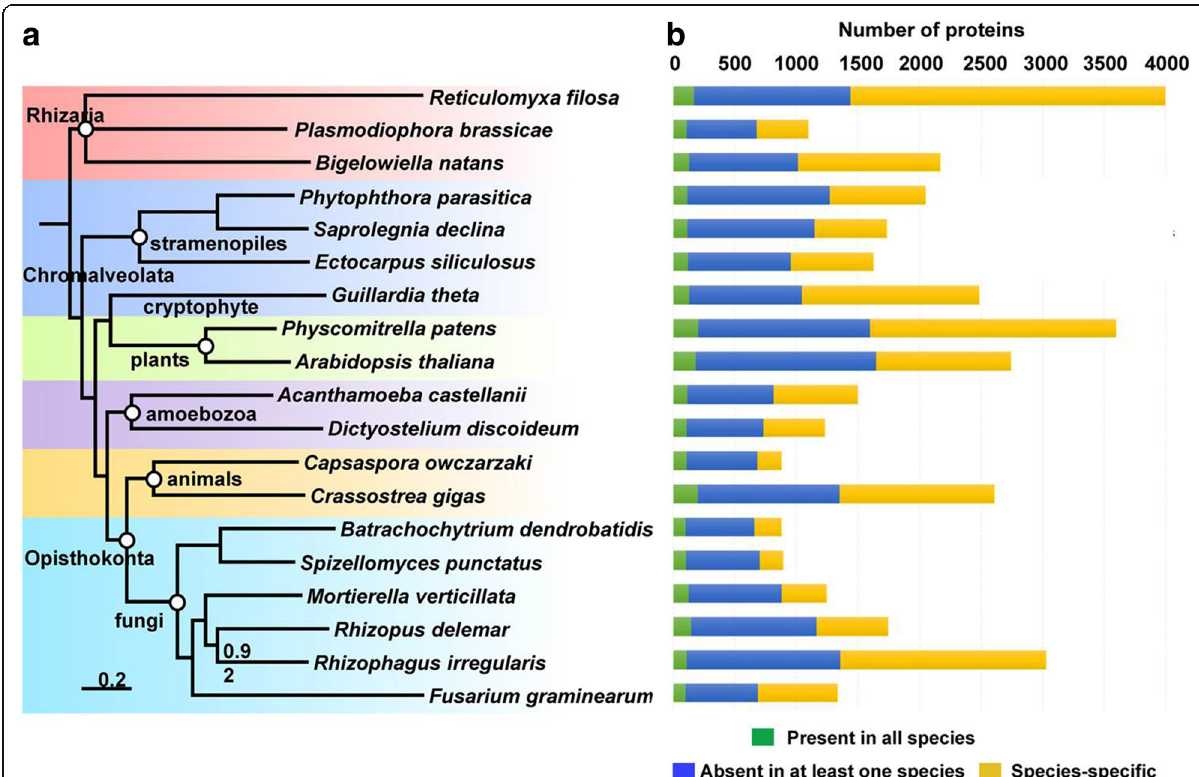
Fig. 2 Phylogeny and ortholog distribution in Plasmodiophora brassicae and other species. a The phylogeny was constructed by the maximum likelihood method from a concatenated alignment of 90 single-copy orthologs conserved across species. The scale bar of branch length represents 0.2 amino acid-substitutions/site, and the bootstrap values are indicated on nodes (the value of 1 was omitted). Different subphylum branches are highlighted as follows: Rhizaria, red; Chromalveolata, dark blue; plants, light green; amoebozoa, light purple; animals, dark orange; fungi, light blue. b The colored bars represent orthologous proteins identified using OrthoMCL in the species shown in A. The bars are divided into 3 categories: present in all species (green), absent in at least one other species (blue), species-specific